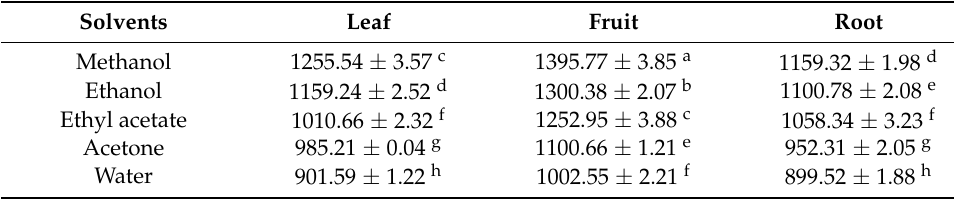
Table 3. Determined by the phosphomolybdenum method of P. ginseng .